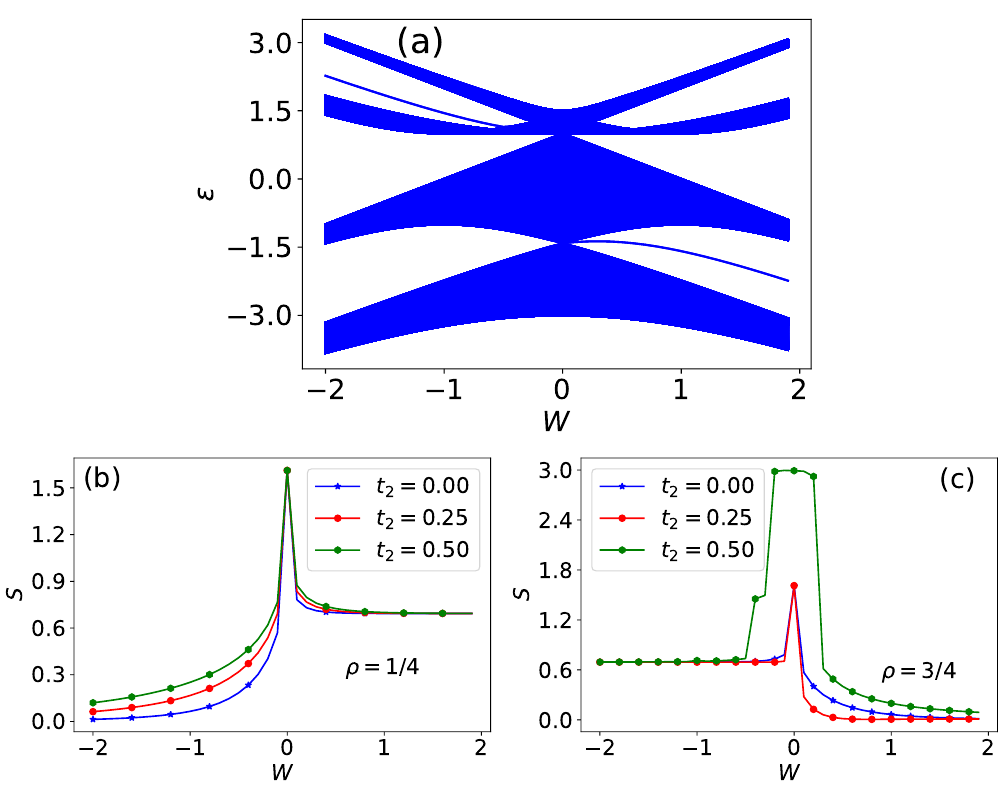
Figure 5: (a) Energy spectrum as a function of W for a non-zero NNN hopping = 0.5. (b,c) Entanglement entropy as a function of W for different values of t 2 NNN hopping t with OBC: (b) for ρ = 1 / 2; (c) for ρ = 3 / 4. Here N = 2000 and 2 = t 1